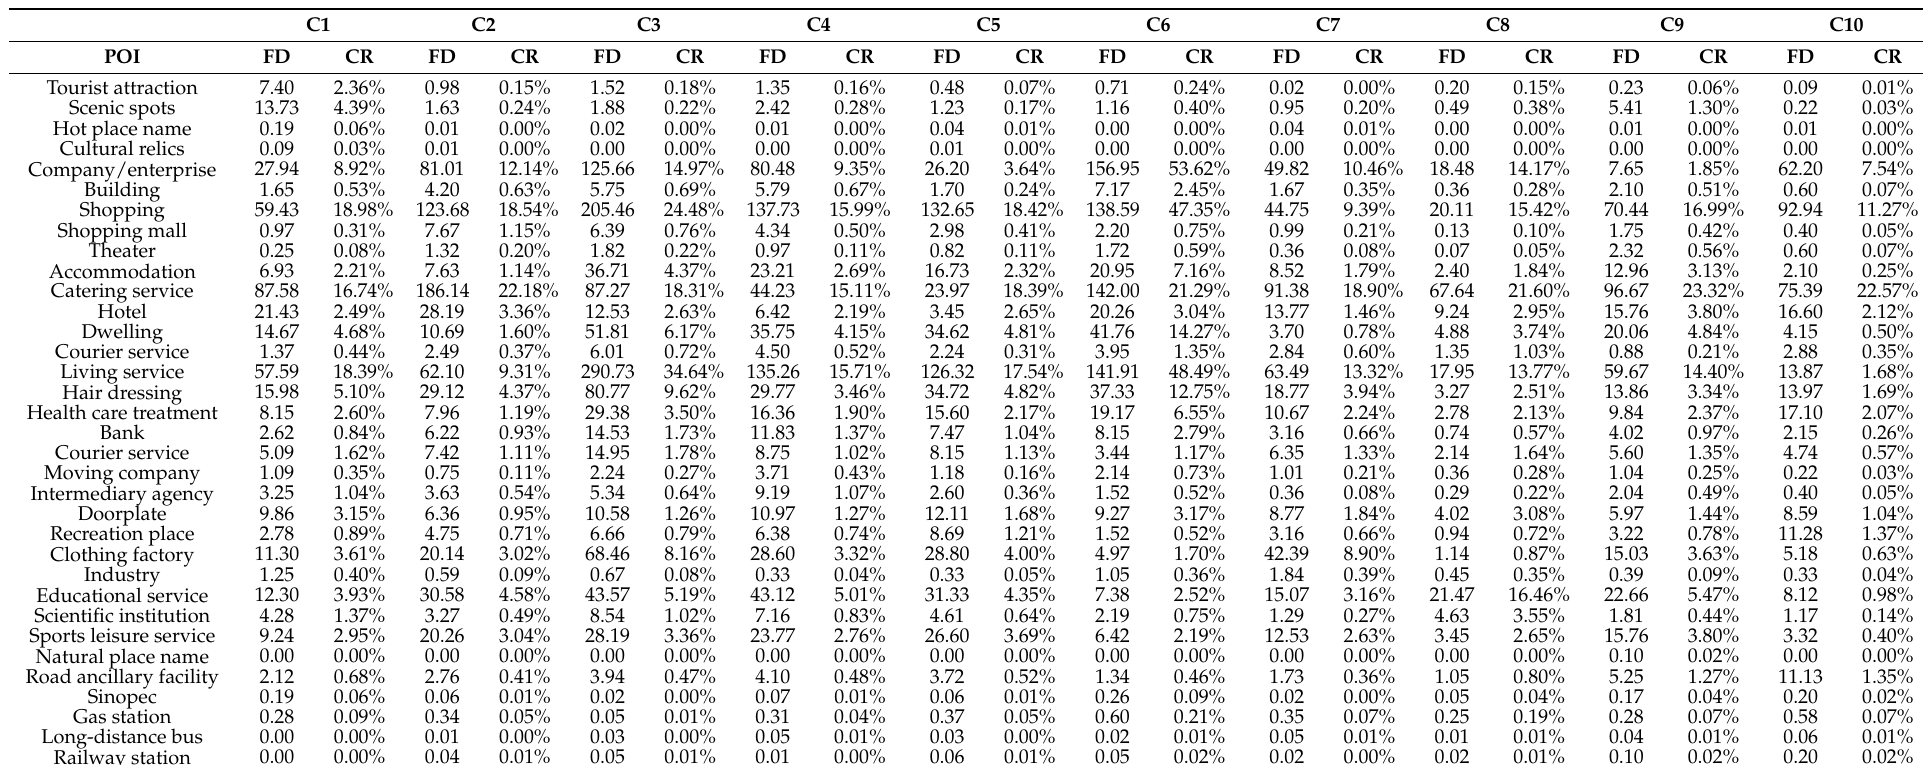
Table 2. Frequency Density (FD) and Category Rate (CR) of each